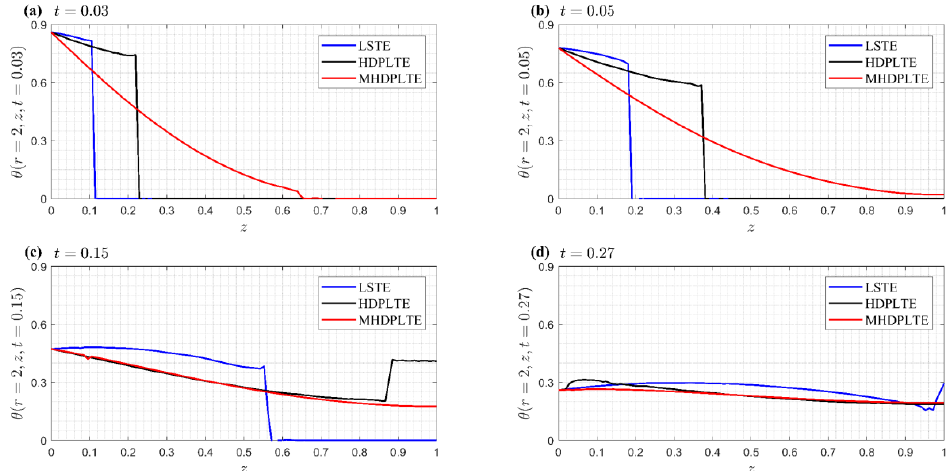
Figure 4. Comparison among the temperature profiles resulted from the three thermoelastic models at 𝑟 = 2 and different instants: ( a ) 𝑡 = 0.03 , ( b ) 𝑡 = 0.05 , ( c ) 𝑡 = 0.15 and ( d ) 𝑡 = 0.27 .